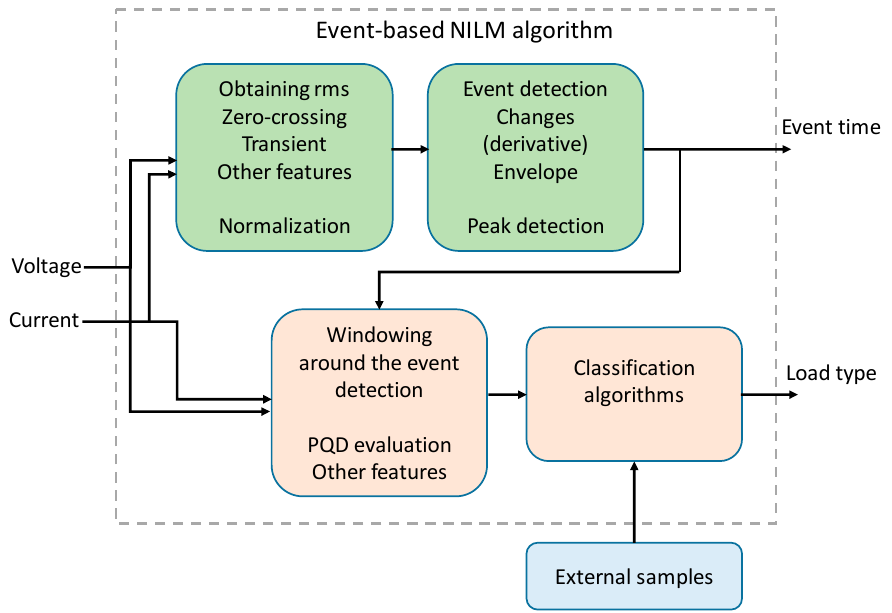
Figure 3. Block diagram of an event-based NILM algorithm to obtain event times and types of loads involved in each event.